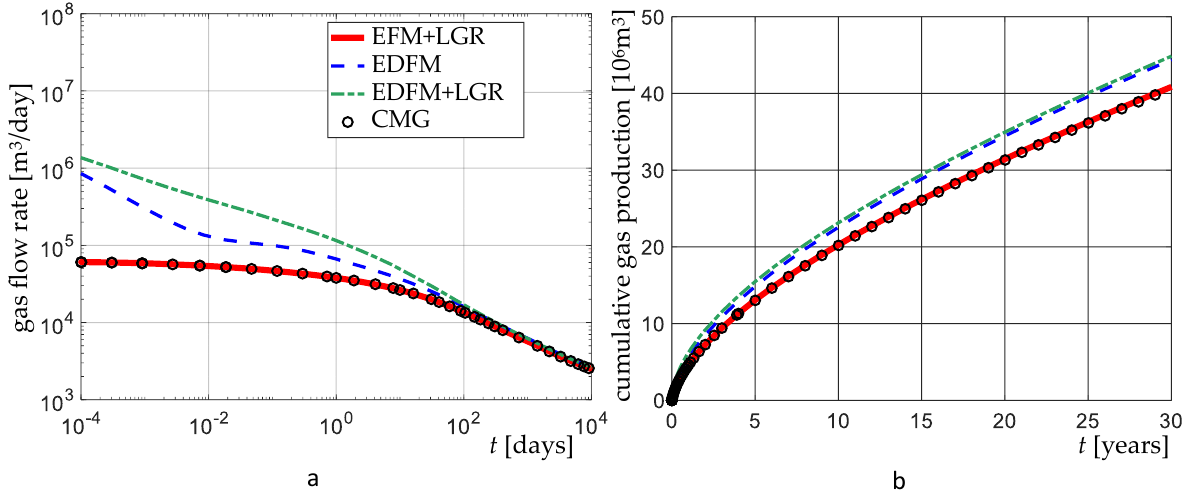
Figure 14. Comparison of the results provided by ShOpen and CMG in terms of ( a ) gas flow rate and ( b ) cumulative production, for VE1B with C f 5 mD-ft.